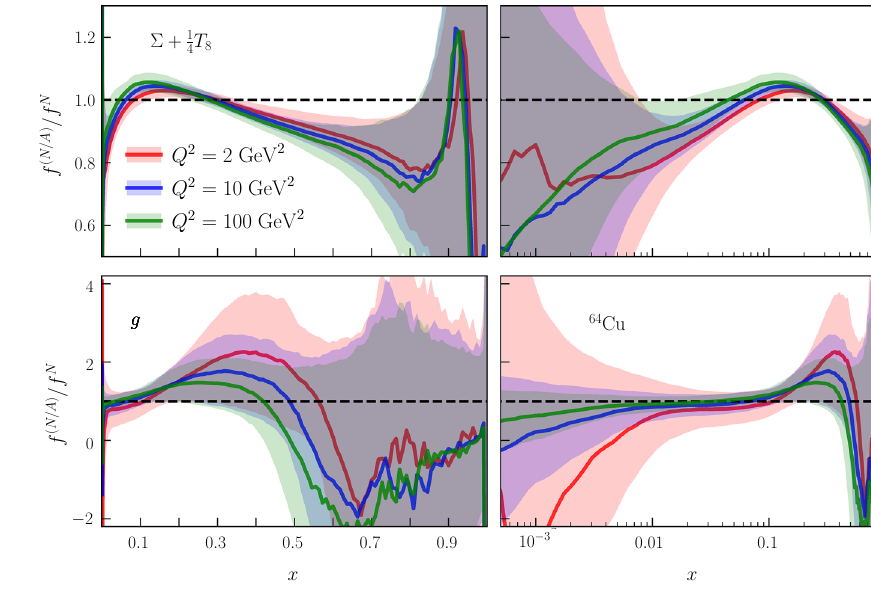
Fig. 18 Same as Fig. 17, but now for the dependence of the nuclear modifications of 64 Cu on the momentum transfer Q 2 . The ratios are given for Q 2 = 1 GeV 2 (red), 10 GeV 2 (blue), and 100 GeV 2